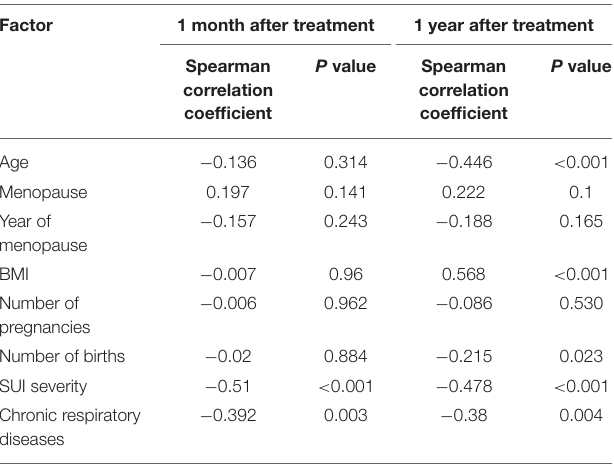
TABLE 4 | Analysis of related factors of curative effect of Modified Buzhong Yiqi Decoction after 1 month and 1 year of